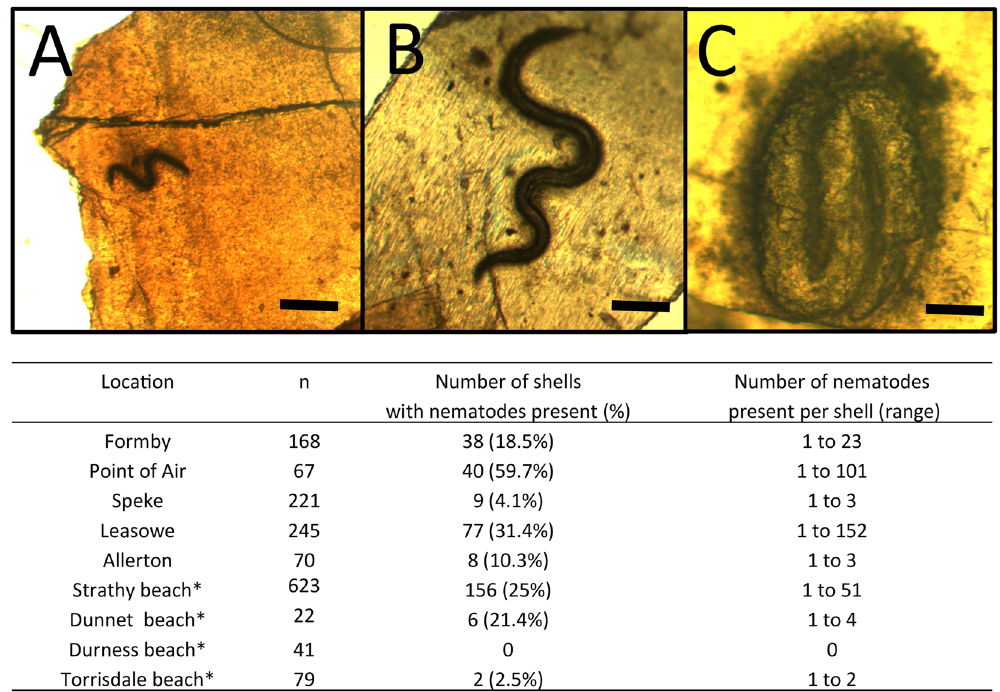
Figure 3. Wild caught snails encase nematodes in their shells. C. nemoralis and C. hortensis from around the U.K have many nematodes present in the inner aperture of their shells ( A – C ). The table below details the total numbers of C. nemoralis and C. hortensis shells examined. C. hortensis were collected from locations marked with * . Scale bars in ( A , B and C ) represent 500 μ m, 1 cm and 100 μ m,